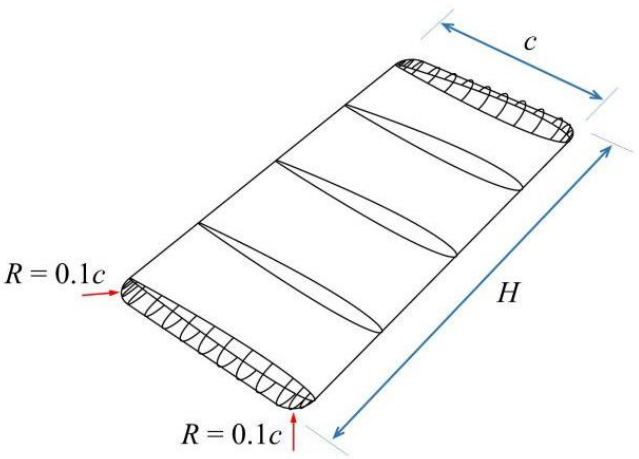
Figure 2. Three-dimensional geometric shape of the flapping hydrofoil.